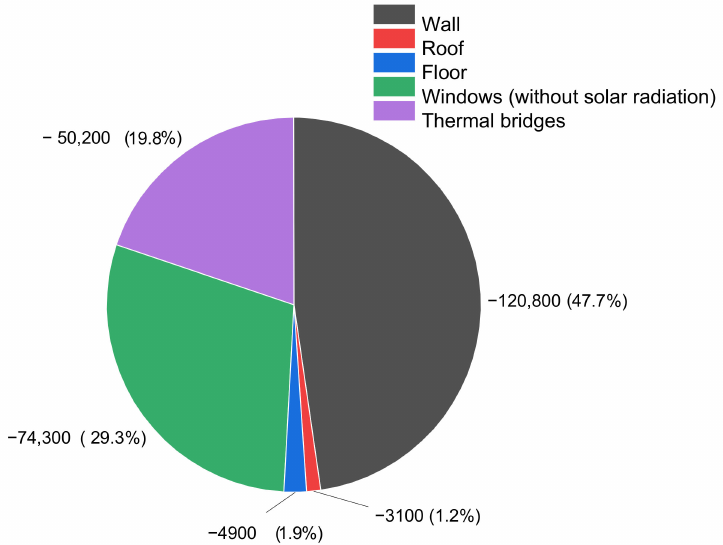
Figure 12. Annual sensible heat transmission through the envelope (kWh) in case A (no low-E